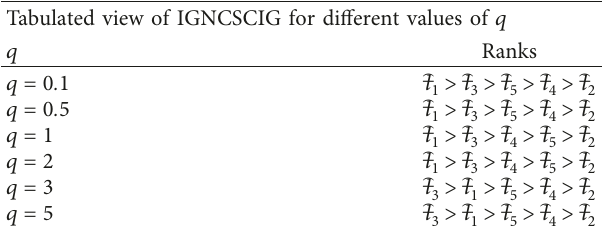
Figure 2: Graphical view of IGNCSCIA.